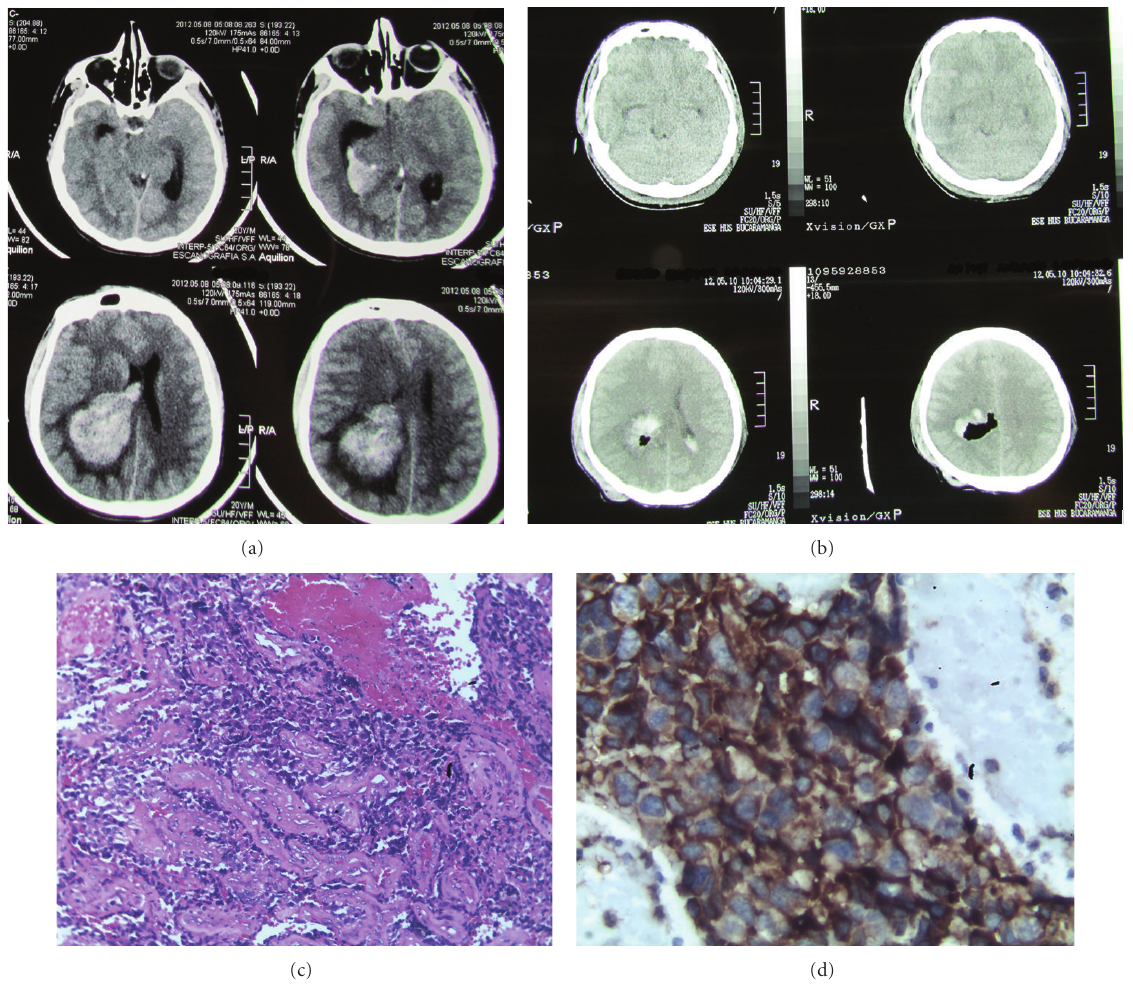
Figure 2: The brain CT. Parietotemporal tumor and intraparenchymal hemorrhage associated left ventricular drainage system and midline shift (a) and after resection demonstrates no residual tumor and a resolve mass e ff ect (b). Histopathology shows high mitotic index and multinucleated giant cells. Hematoxylin and eosin stain (c). Immunohistochemistry confirmed the glial origin and high proliferation rate and PAFG positive